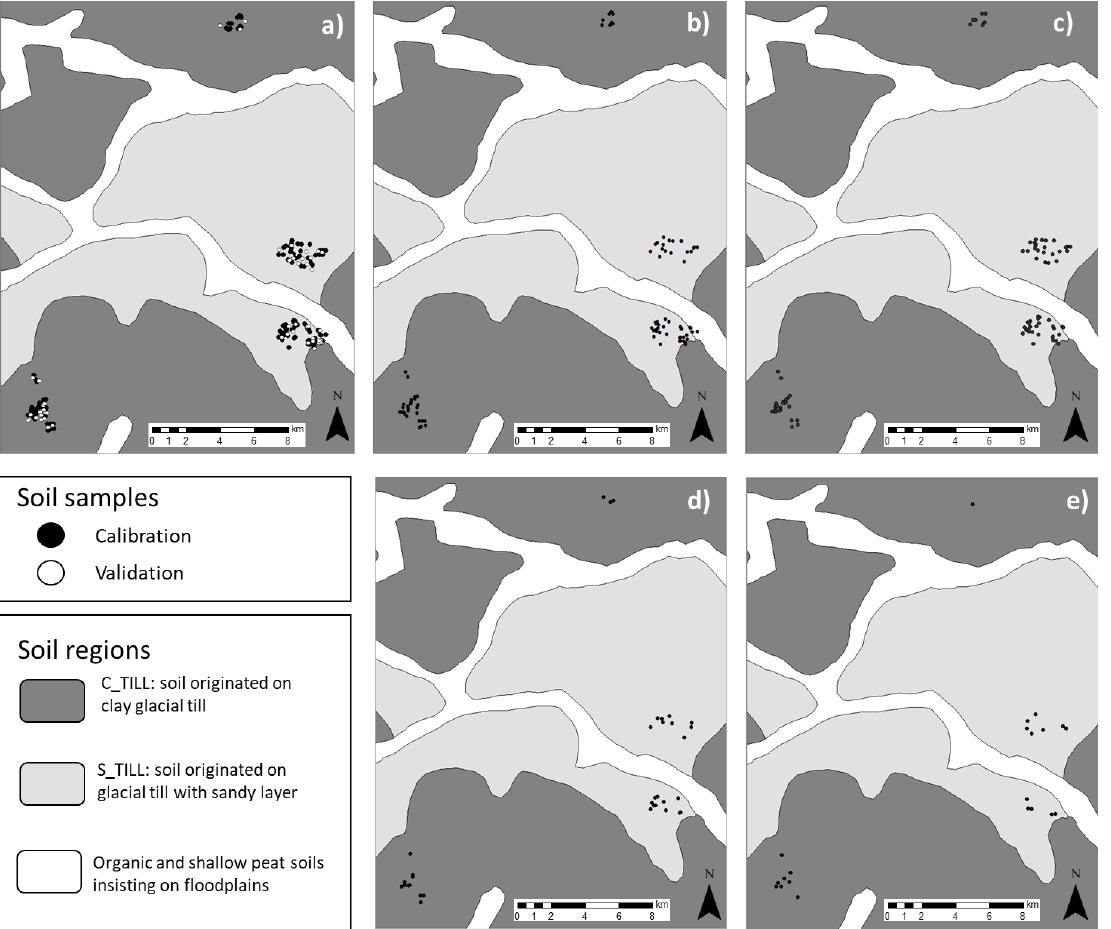
Figure 9. Kernel density estimate plot for the SOC values of the CAL dataset. The circles indicate the SOC content of the samples selected by the Puchwein (PU), SELECT (SW), Kennard – Stones and conditioned Latin Hypercube (cLHS) algorithms.